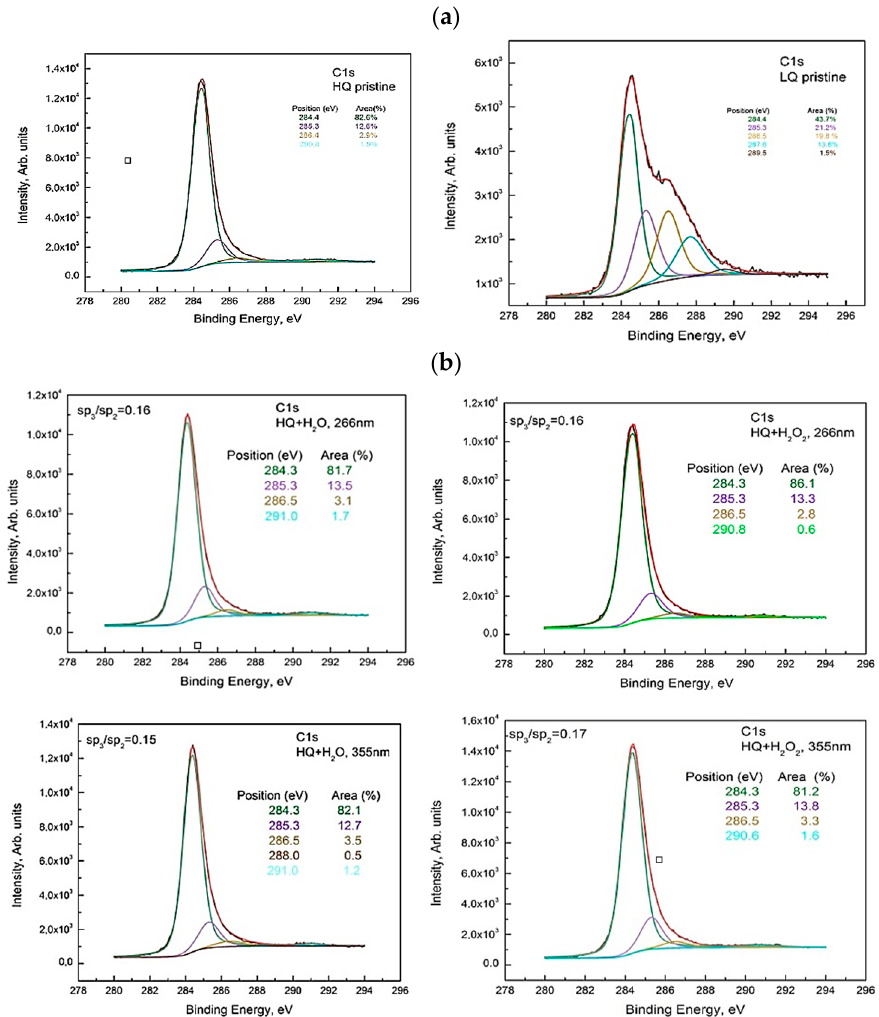
Figure 2. Deconvolution of the C1s line of the XPS spectrum taken from ( a ) HQ pristine and LQ pristine ( b ) HQ+H 2 O and HQ+H 2 O 2 sediment for both wavelengths 266 nm and 355 nm.